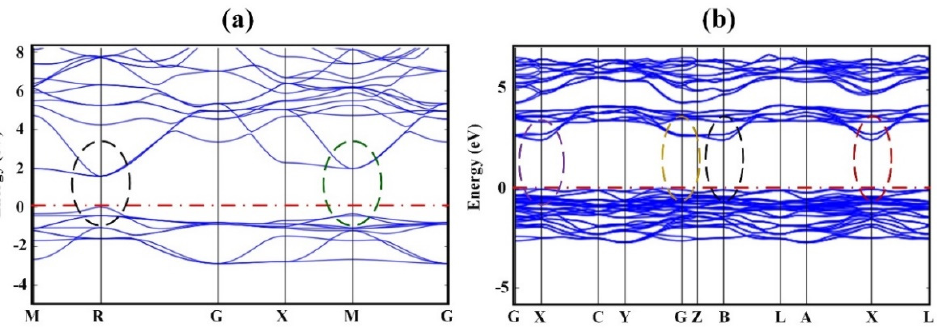
Figure 2. Calculated band structure of the pure inorganic perovskite, ( a ) CsPbI 3 − cubic, ( b ) CsPbI 3 − Orthorhombic.